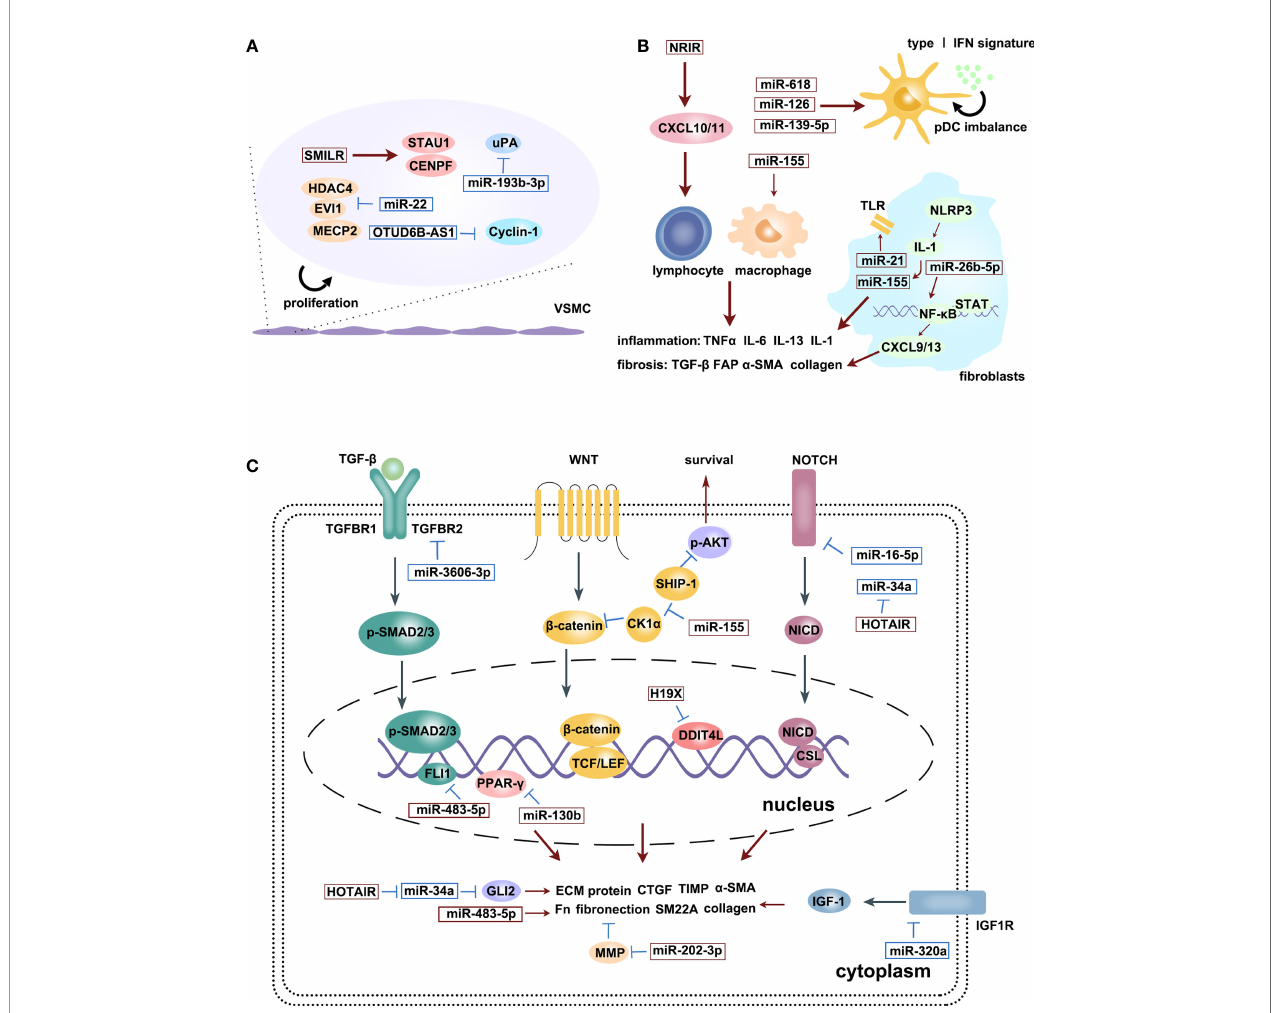
FIGURE 2 | The regulatory effects of various miRNAs and lncRNAs involved in SSc process: microvascular changes (A) , immune activation (B) and fi brosis (C) . Upregulation (red squares) and downregulation (blue squares) of diverse ncRNAs participate in different signaling pathways, promoting SSc progression. Red arrows are promotion symbols, blue lines are inhibition